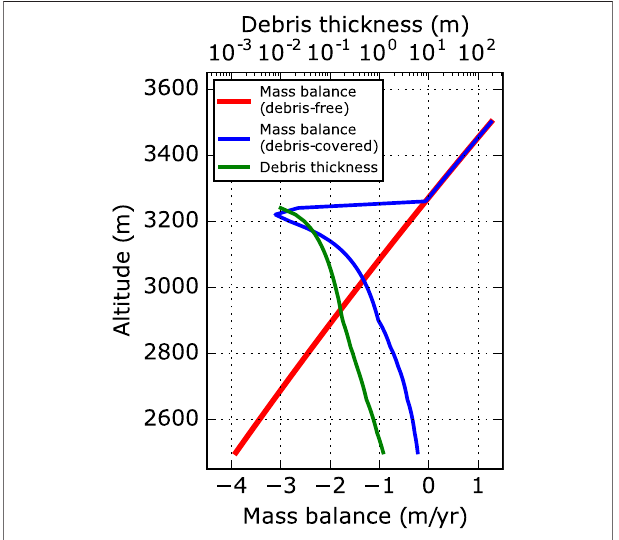
FIGURE 1 | Mass balance gradient used in the basic experiments for clean-ice conditions (red) compared with an example mass balance gradient from a debris-covered glacier (blue). The green curve indicates the corresponding example debris thickness pro fi le.